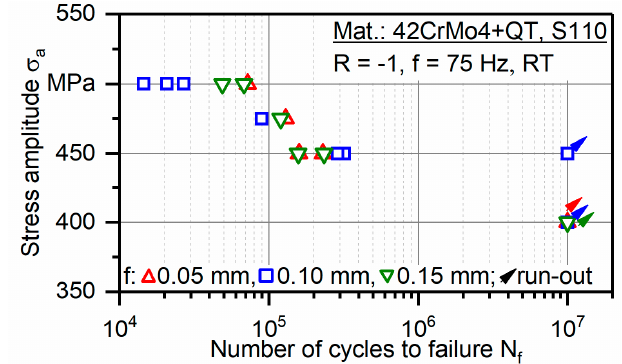
Figure 11. Woehler diagram for S110 specimens and feed rates from 0.05 to 0.15 mm.